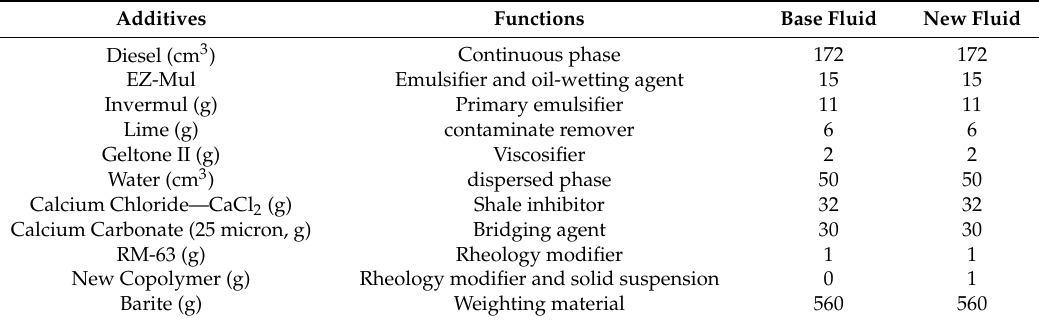
Table 1. Drilling fluid formulation for lab scale, equivalent to 1